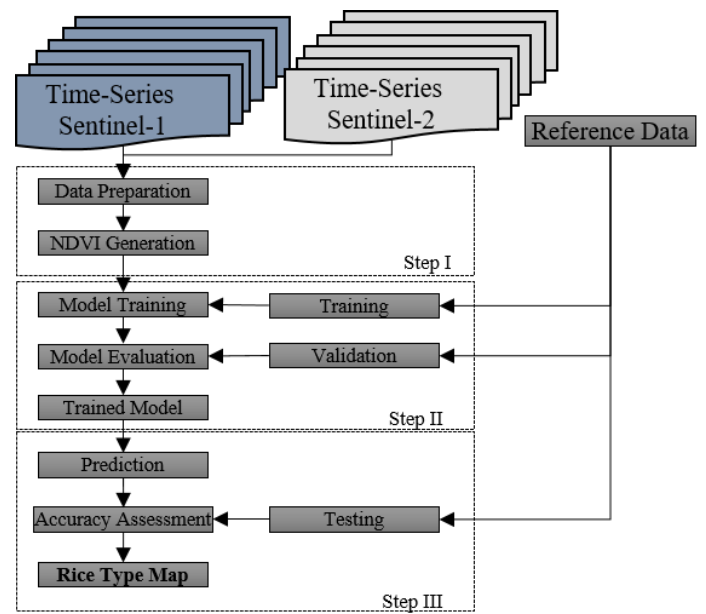
Figure 4. Overview of the proposed framework for rice-type mapping.